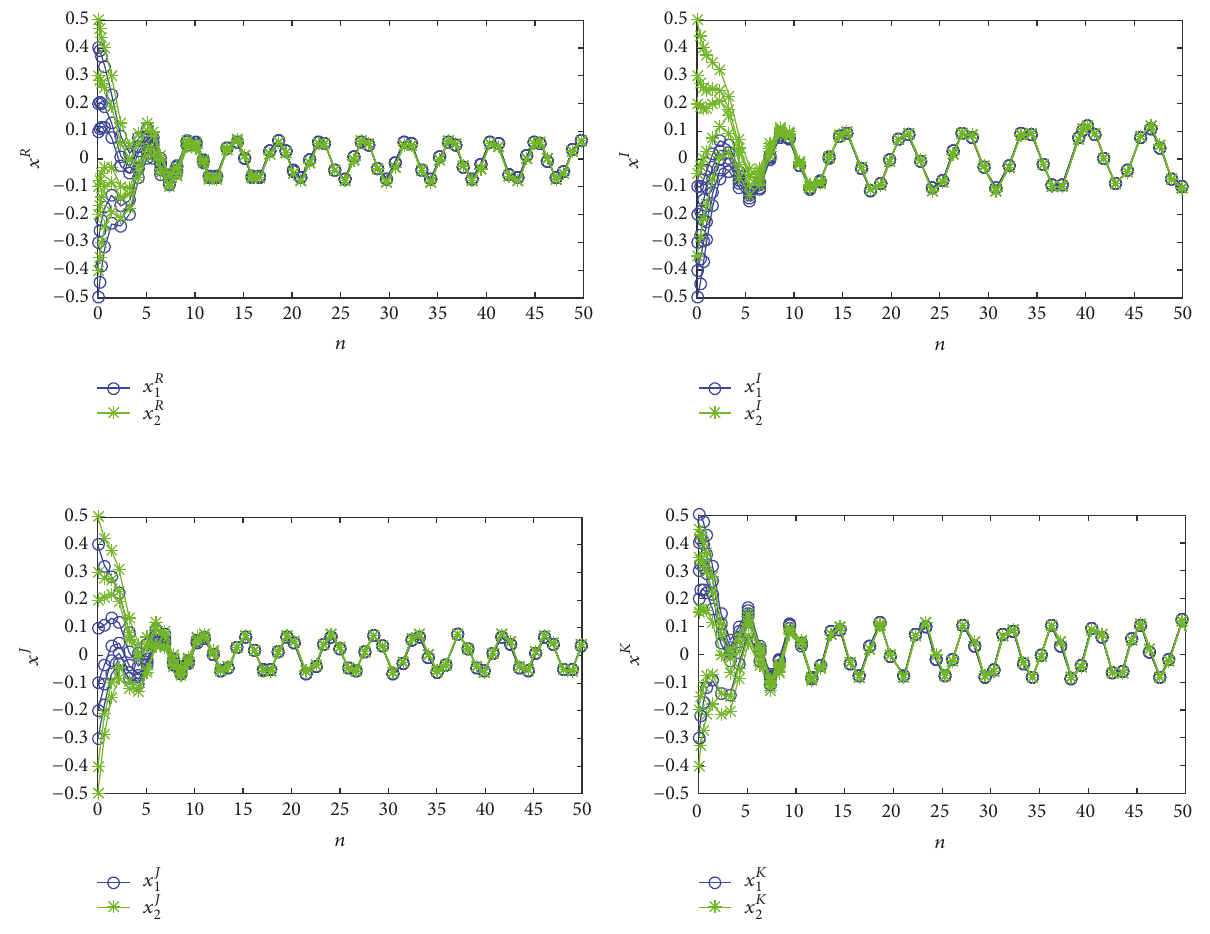
Figure 2: Transient states of four parts with discrete time 𝑡 of (58) in Example